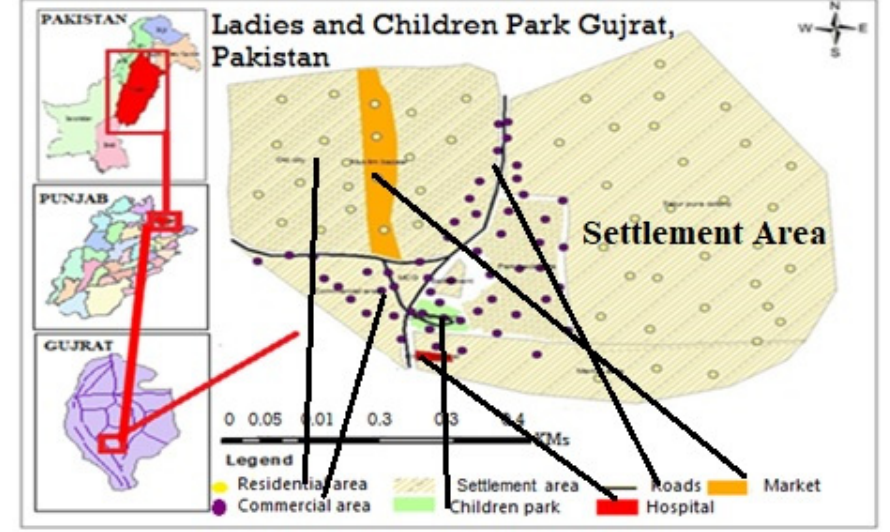
Figure 2. Map of Study Area.